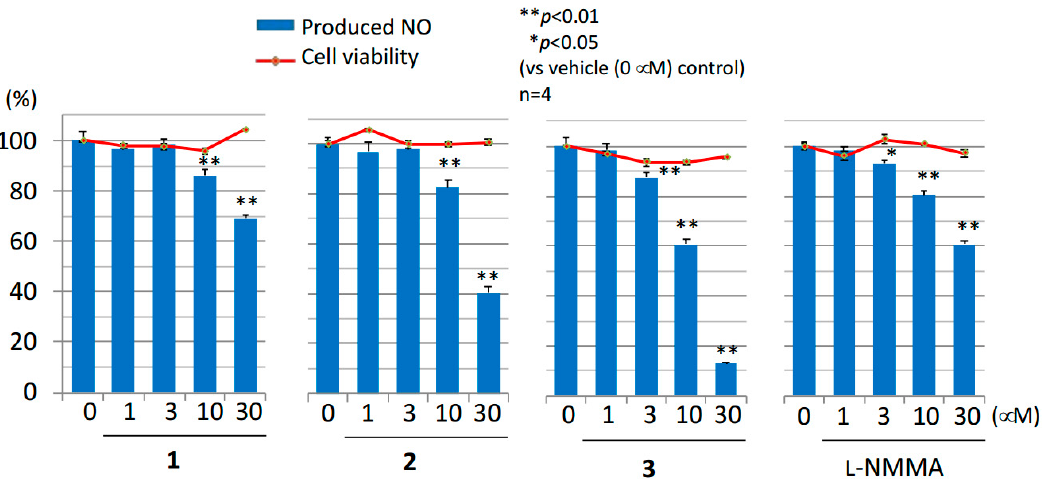
Figure 4. Inhibitory activities on nitic oxide (NO) production and cytotoxicities of Compounds 1 – 3 and N G ‐ monomethyl ‐ L ‐ arginine acetate ( L ‐ NMMA). Each value represents the mean and the standard error (S.E.) of four determinations. Significant differences from the vehicle control (0 μ M) group shown as: * p < 0.05 and ** p < 0.01 in the NO inhibitory assay.